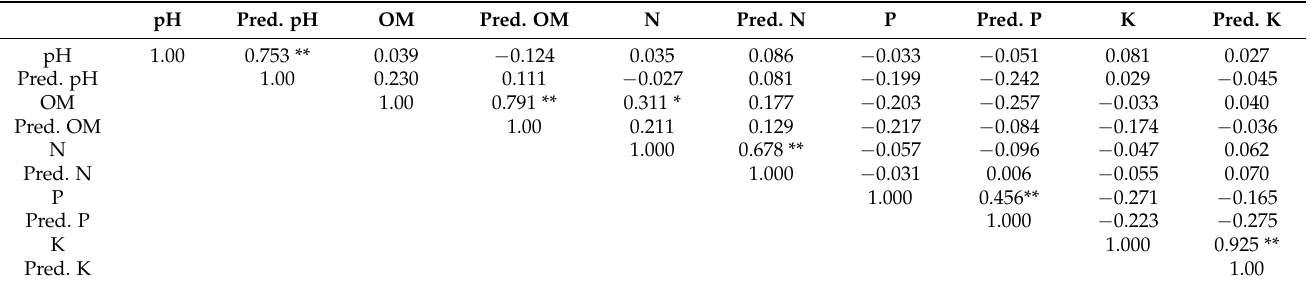
Table 7. Spearman correlations between original and predicated soil properties.